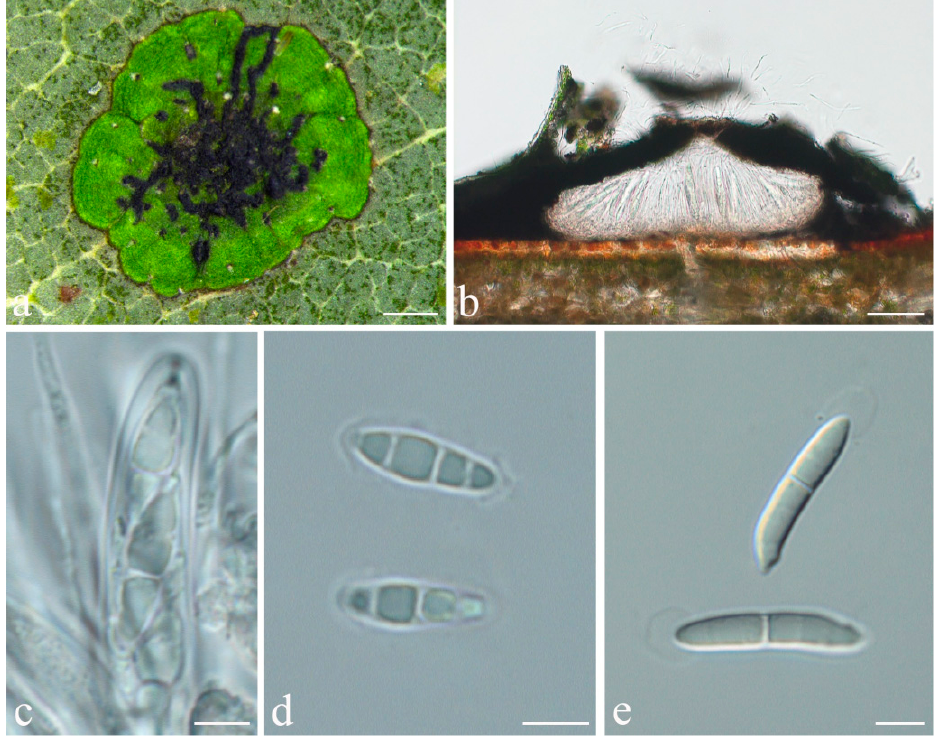
Figure 13. Strigula pycnoradians sp. nov. (holotype, HMAS–L0139611). ( a ) Thallus; ( b ) perithecia; ( c ) asci; ( d ) ascospores; ( e ) macroconidia. Scale bars: ( a ) = 300 μ m, ( b ) = 50 μ m, ( c – e ) = 5 μ m.